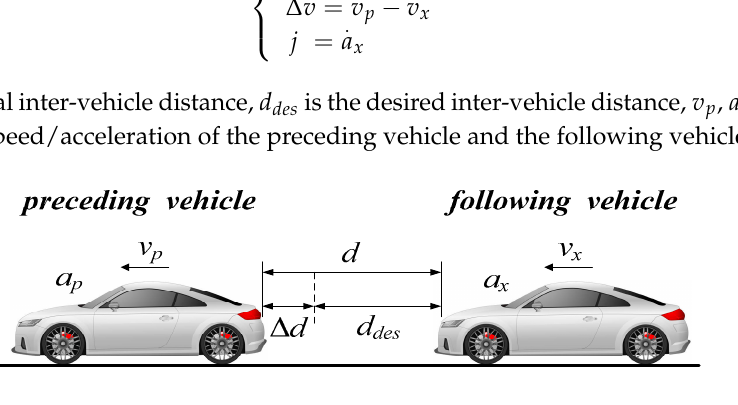
Figure 4. Sketch of longitudinal car-following.